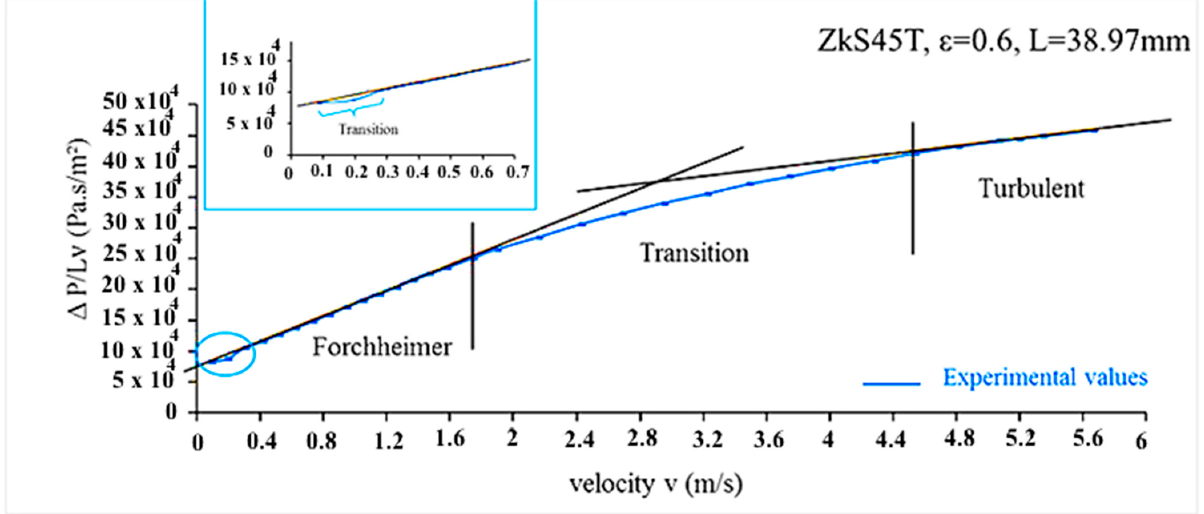
Figure 5. Delimitation of different regimes identified when air flows through ESR open-cell foams. It seems that all samples present nonlinear turbulence trends even for low velocity (v ~ 0.4 m/s).